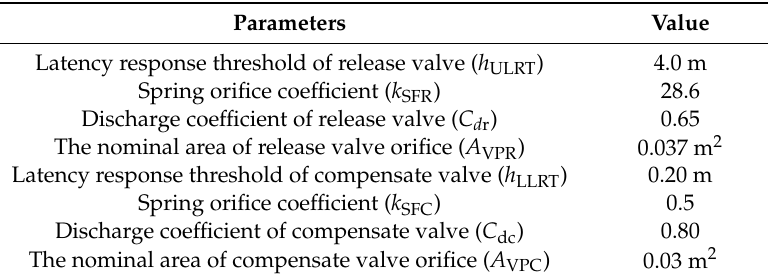
Table 2. Parameters of the SAC.